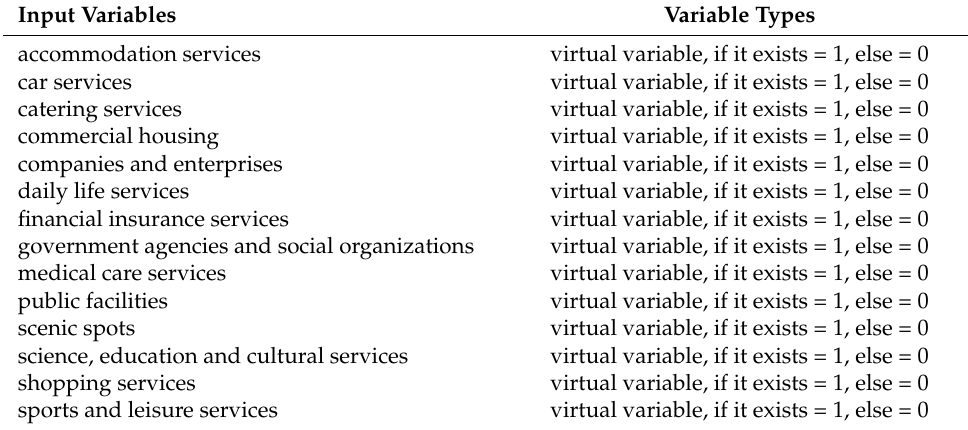
Table 3. The classes and basic characters of input variables of cosine